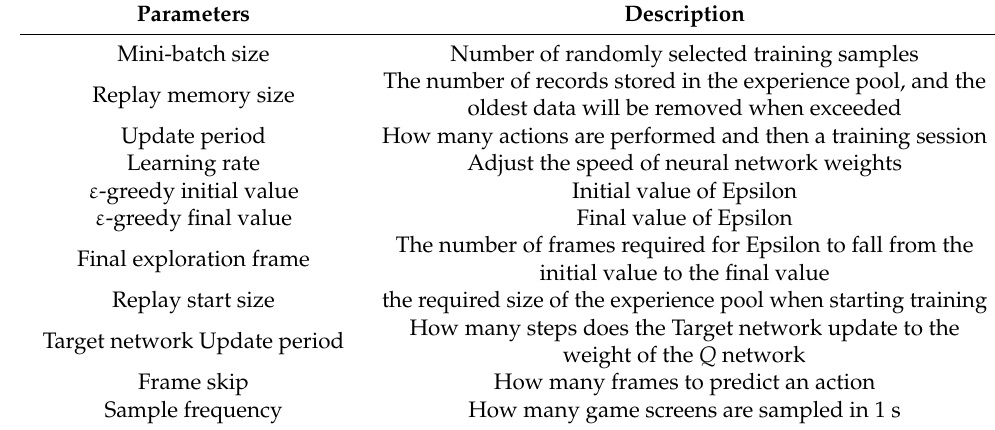
Table 5. Parameter of